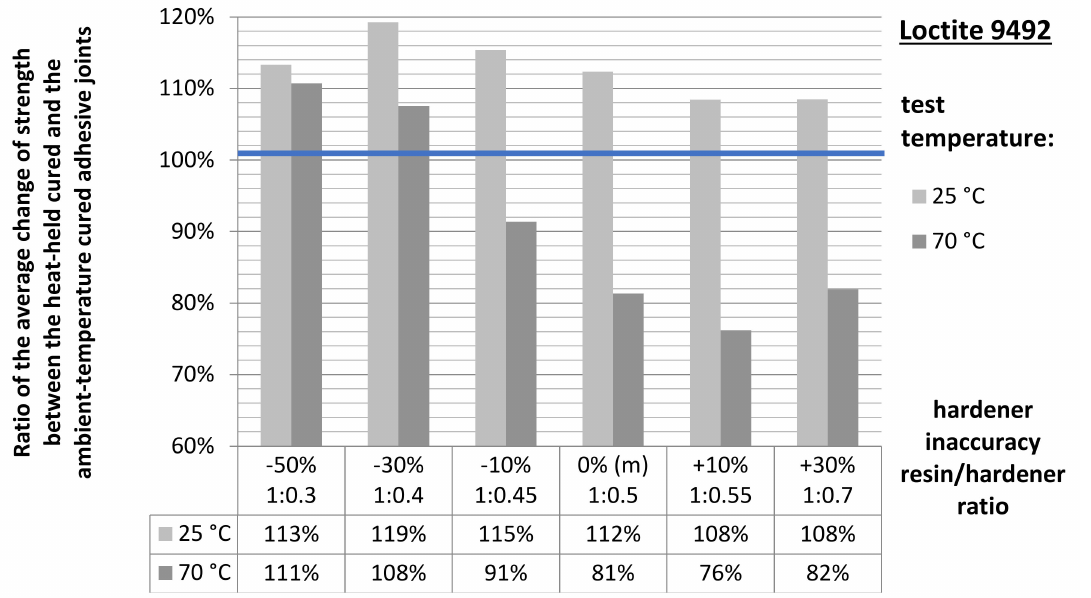
Figure 12. Average strength ratio of the heat cured to the ambient temperature-cured adhesive